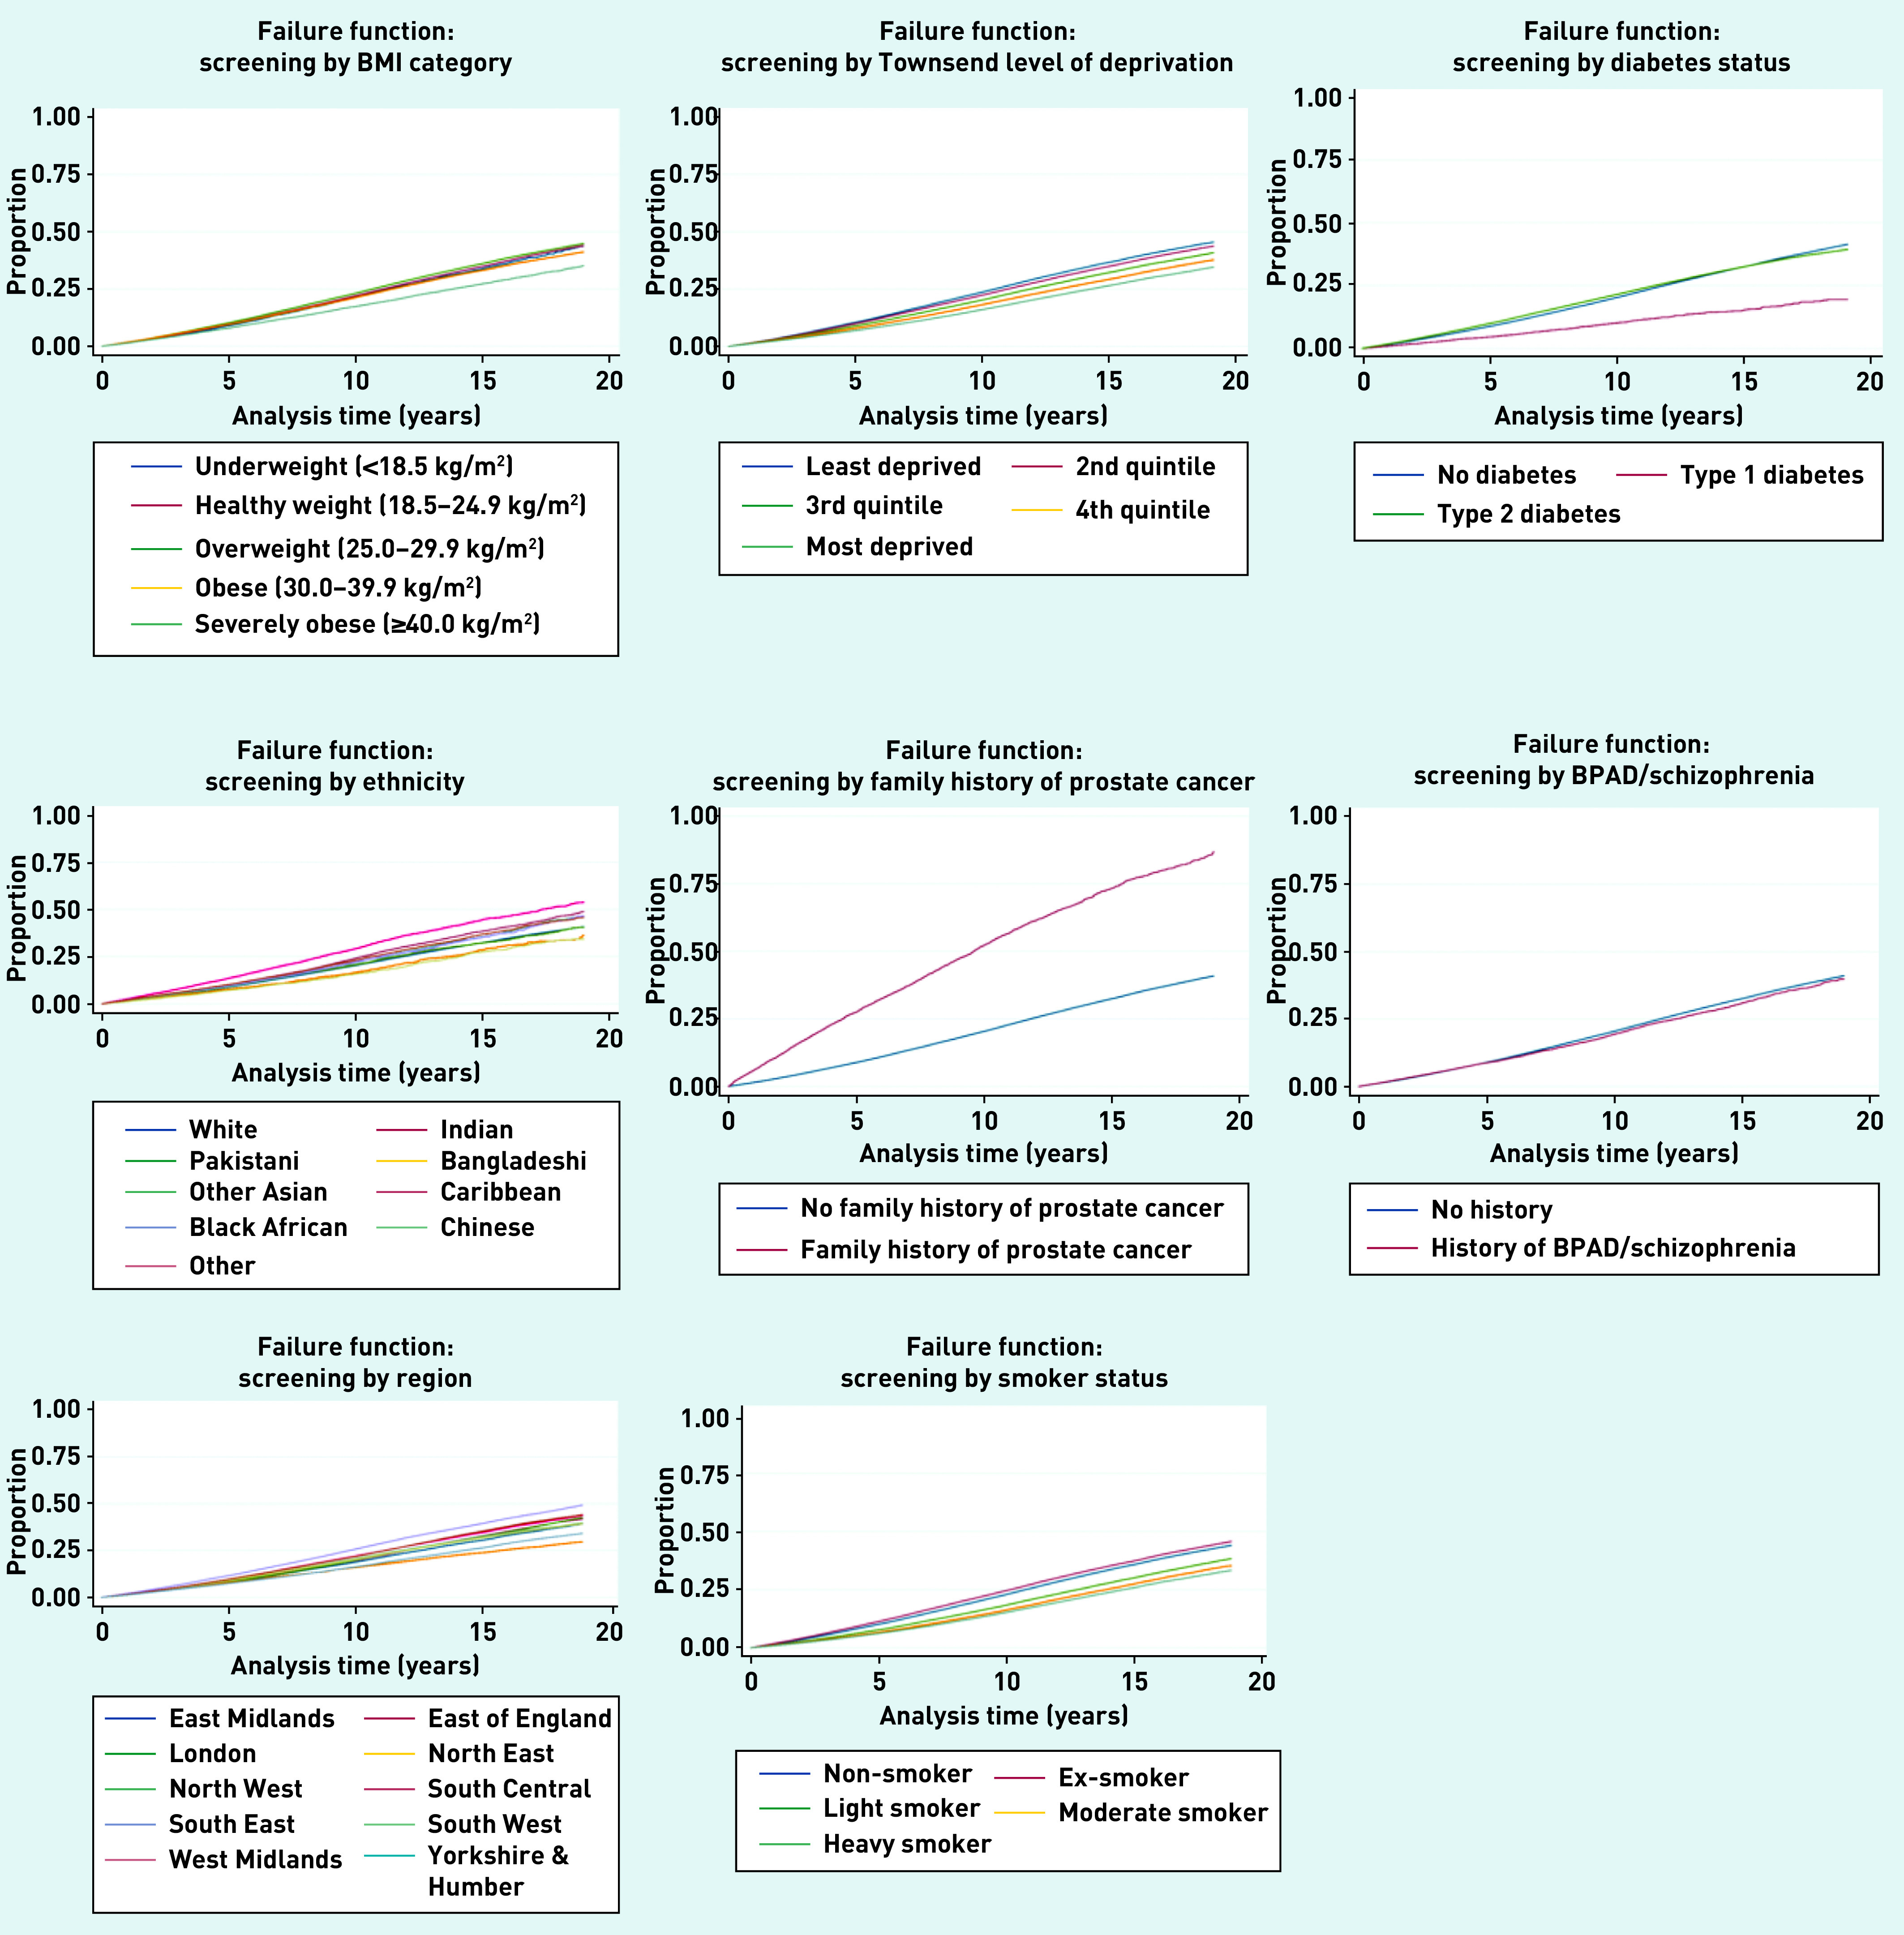
Kaplan–Meier failure functions for factors associated with opportunistic prostate cancer screening uptake.BMI = body mass index. BPAD = bipolar affective disorder.